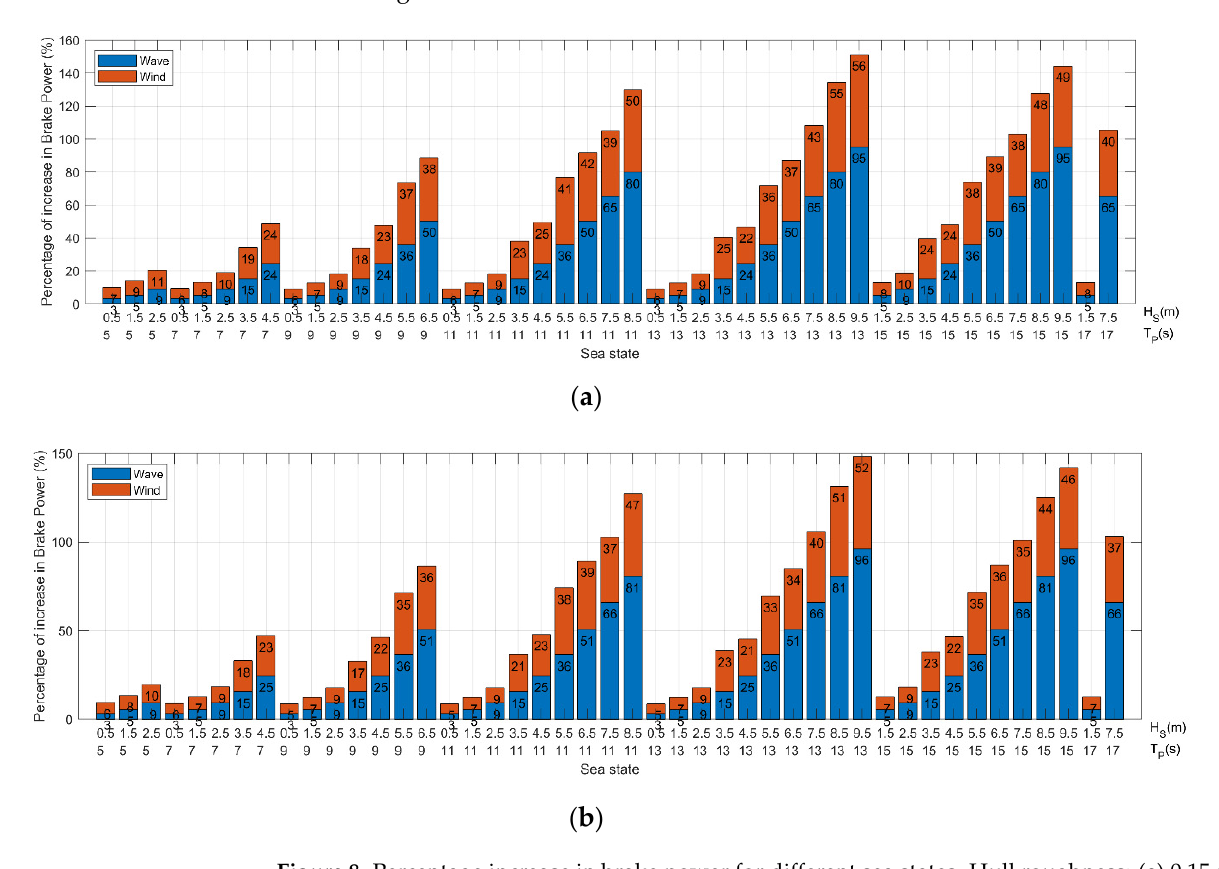
Figure 8. Percentage increase in brake power for different sea states. Hull roughness: ( a ) 0.15 mm; ( b ) 0.55 mm.